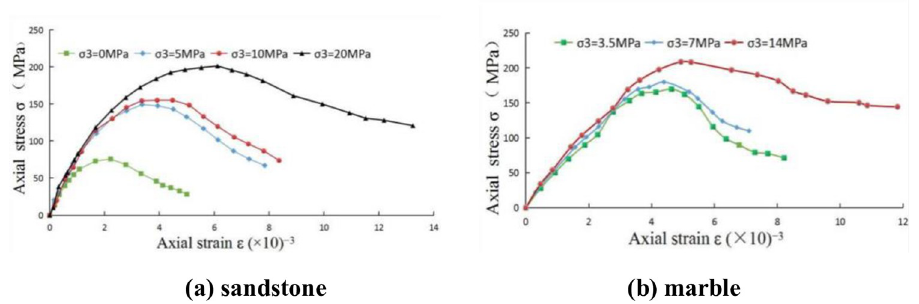
Fig 2. Fitting curves of the proposed model (NMSDM): (a) sandstone; (b)